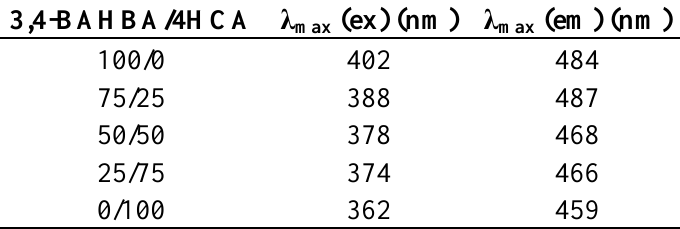
Table 3. Photoluminescence excitation λ BAHBA- co